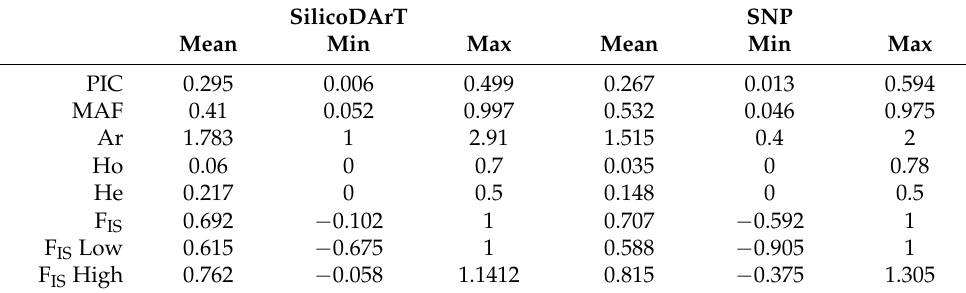
Table 2. Genetic diversity indexes of DArTSeq markers.